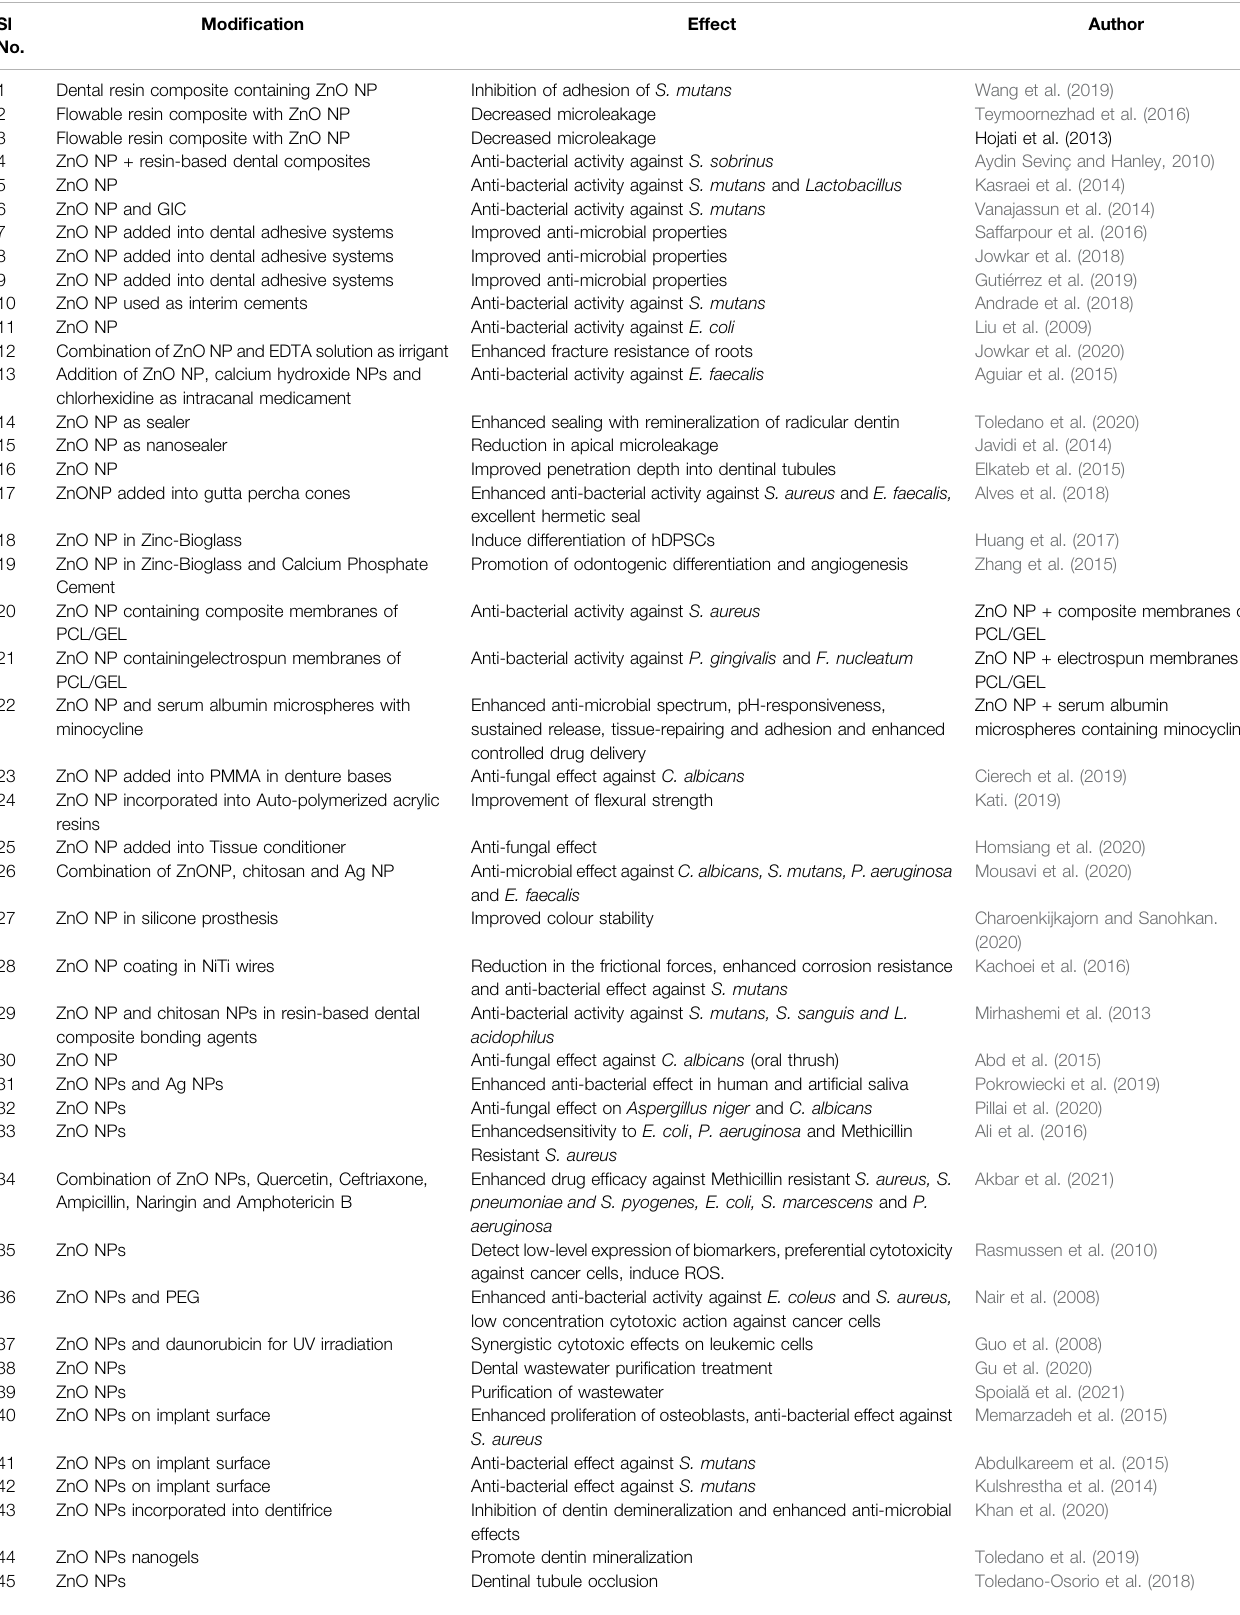
TABLE 1 | Studies focussing on the Applications of ZnO NPs in dentistry. Sl